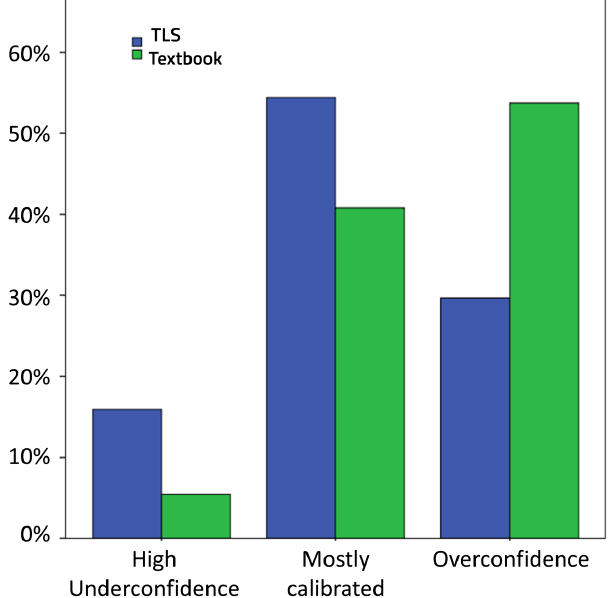
FIG. 8. DPF contrast (green circles) and DPF on confidence items (red diamonds) vs ability quartiles. Whiskers indicate 95% confidence interval. Green (red) circles (diamonds) are slightly shifted toward the right (left) to enhance readability.